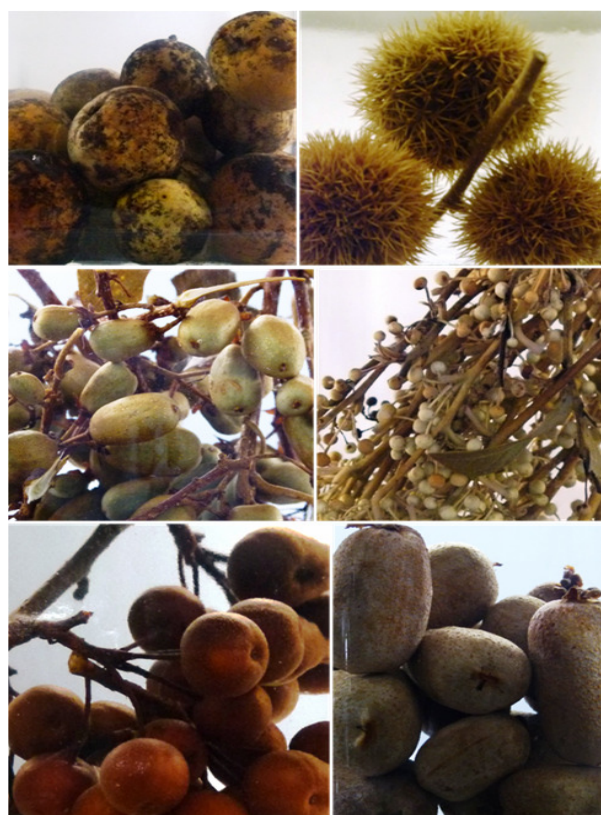
Fig. 9. Local fruits consumed by the Apatani . Left to right: first row - Pecha ( Pyrus pashia ) and Kiira ayi ( Castanopsis hystrix ); second row - Harkhu ayi ( Actinidia chinensis ) and Santero ( Litsea cubeba ); third row - Pitta ayi ( Pyrus calleryana ) and Antitari ayi ( Actinidia callosa